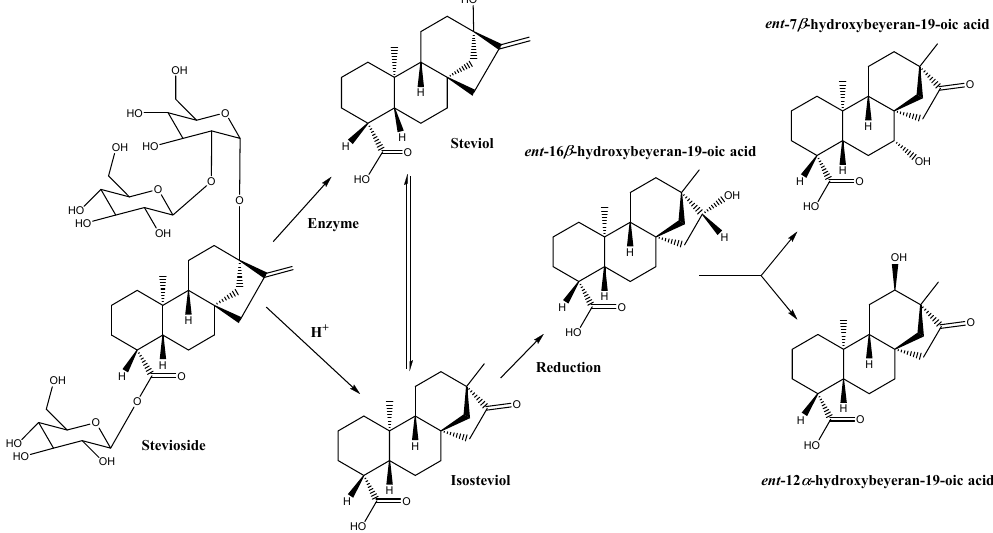
Figure 6. Structures of diterpenoids isolated from microbial transformations of isosteviol. Adapted with permission from Lin et al. [47].